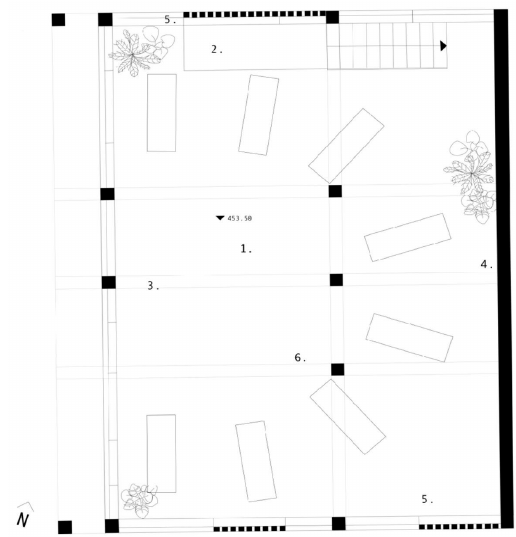
Figure 11. Tri Shala’s first floor—the Yoga space in the tree crown. (1) Yoga space, (2) storage, (3) panoramic view of nature, (4) enclosed construction, (5) sun protection, (6) aerial Yoga (Source: compiled by the author).